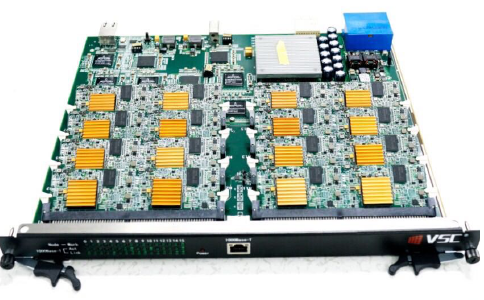
Figure A1: Accelerating cluster with 16 Zynq XC7Z030-3 SoCs.